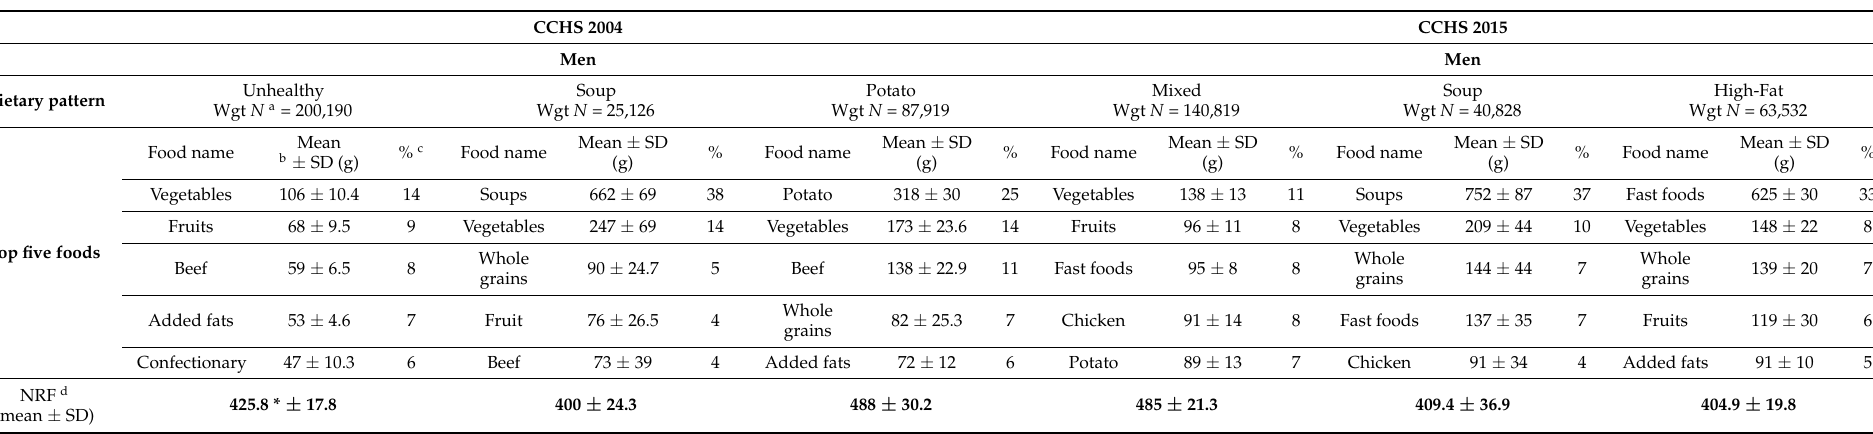
Table 2. Dietary patterns of Indigenous men in 2004 and 2015.